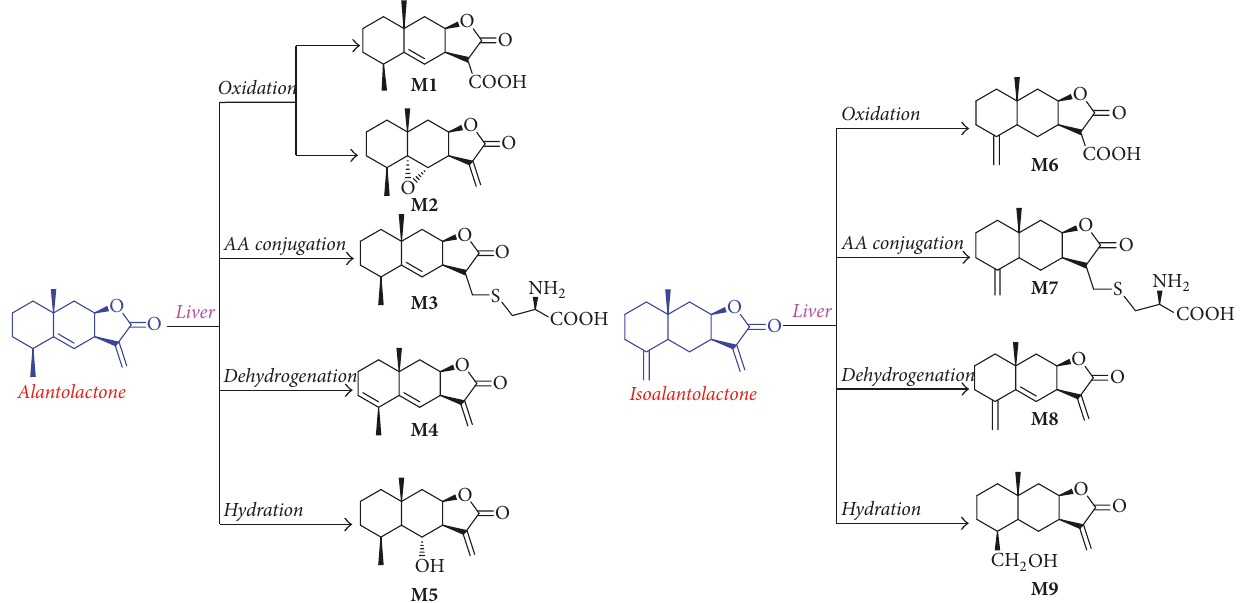
Figure 4: Possible metabolic pathways of alantolactone and isoalantolactone in rat.